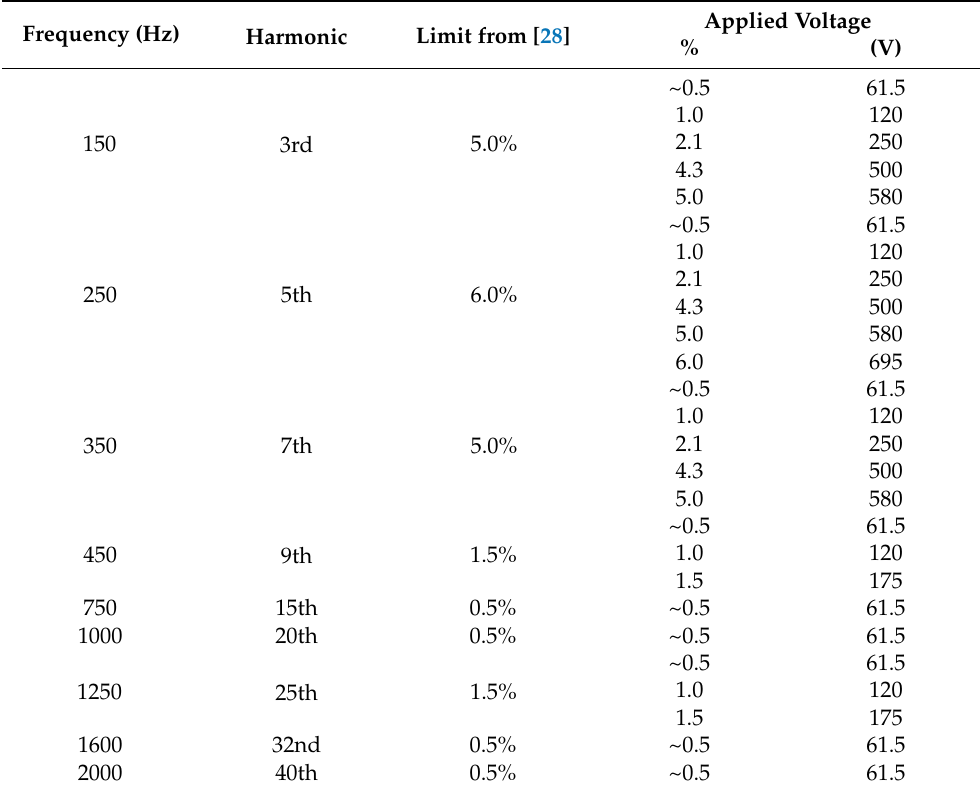
Table 4. Details of the reference